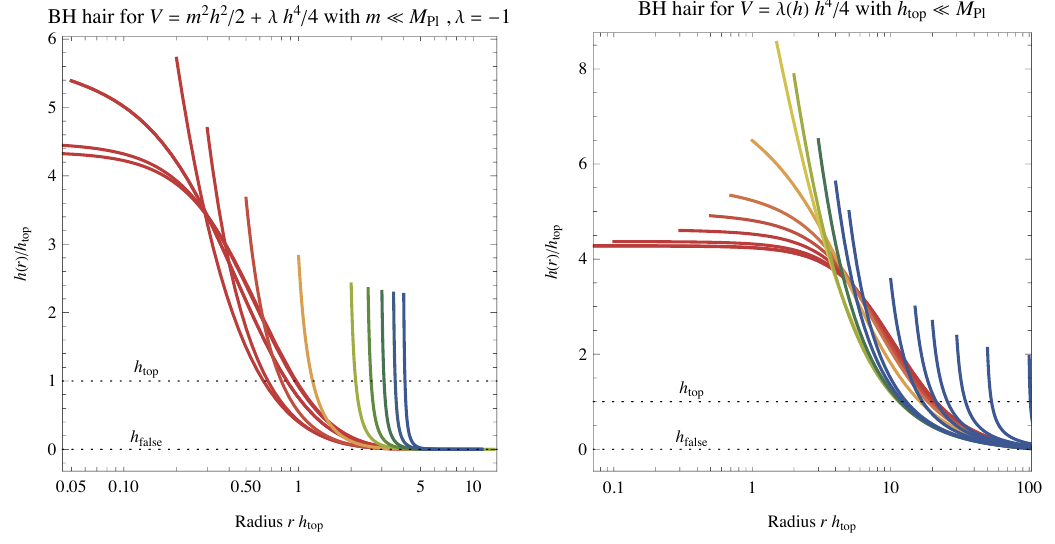
Figure 7 . Scalar hair around black holes with different mass M in = r hor / 2 G . The left plot uses a simple quartic scalar potential; the right plot uses the SM Higgs potential of eq. (2.12). Solutions only exist for h comparable to the instability scale h of the potential. Their time evolution hor top shows that in all cases these solutions are